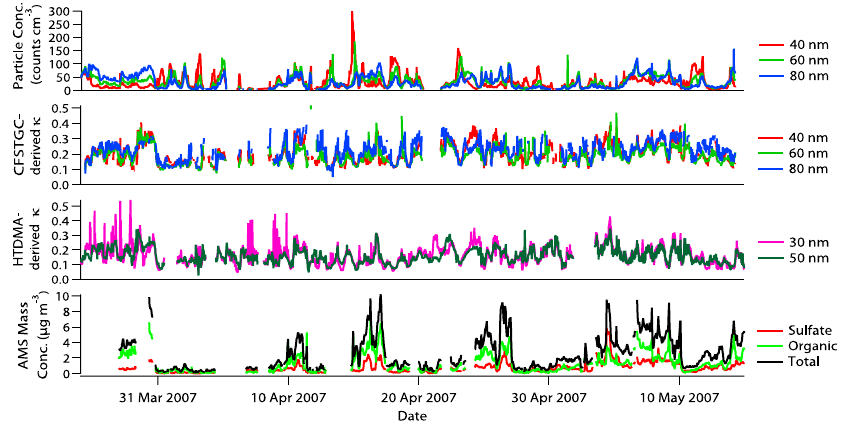
Fig. 4. Temporal variation of HTDMA-derived and CCN-derived κ values, total particle concentration, and AMS mass concentration throughout the campaign.